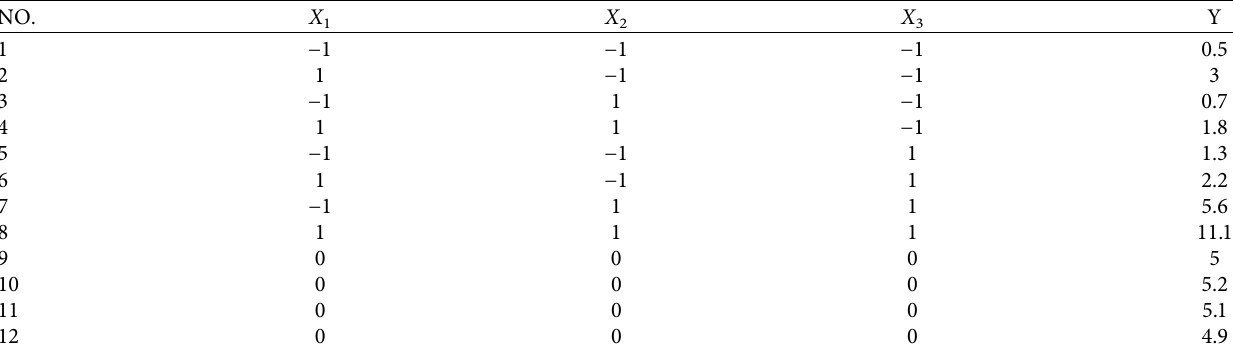
Table 6: Test points and response values in Factorial test.